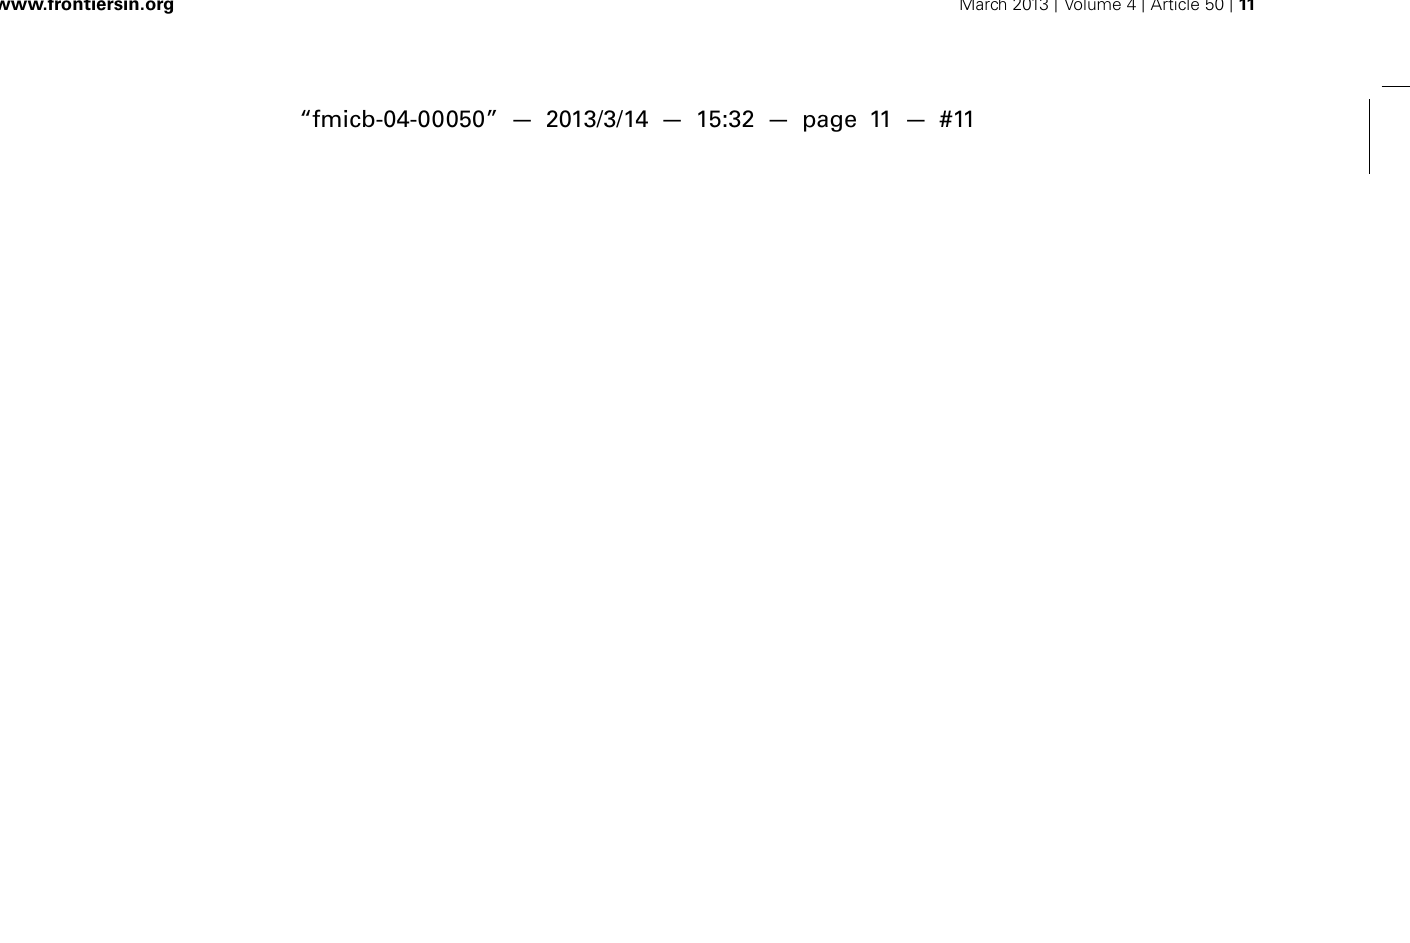
accession numbers. bss , benzylsuccinate synthase; tut , toluene-utilizing (i.e., benzylsuccinate synthase); nms , naphthylmethylsuccinate